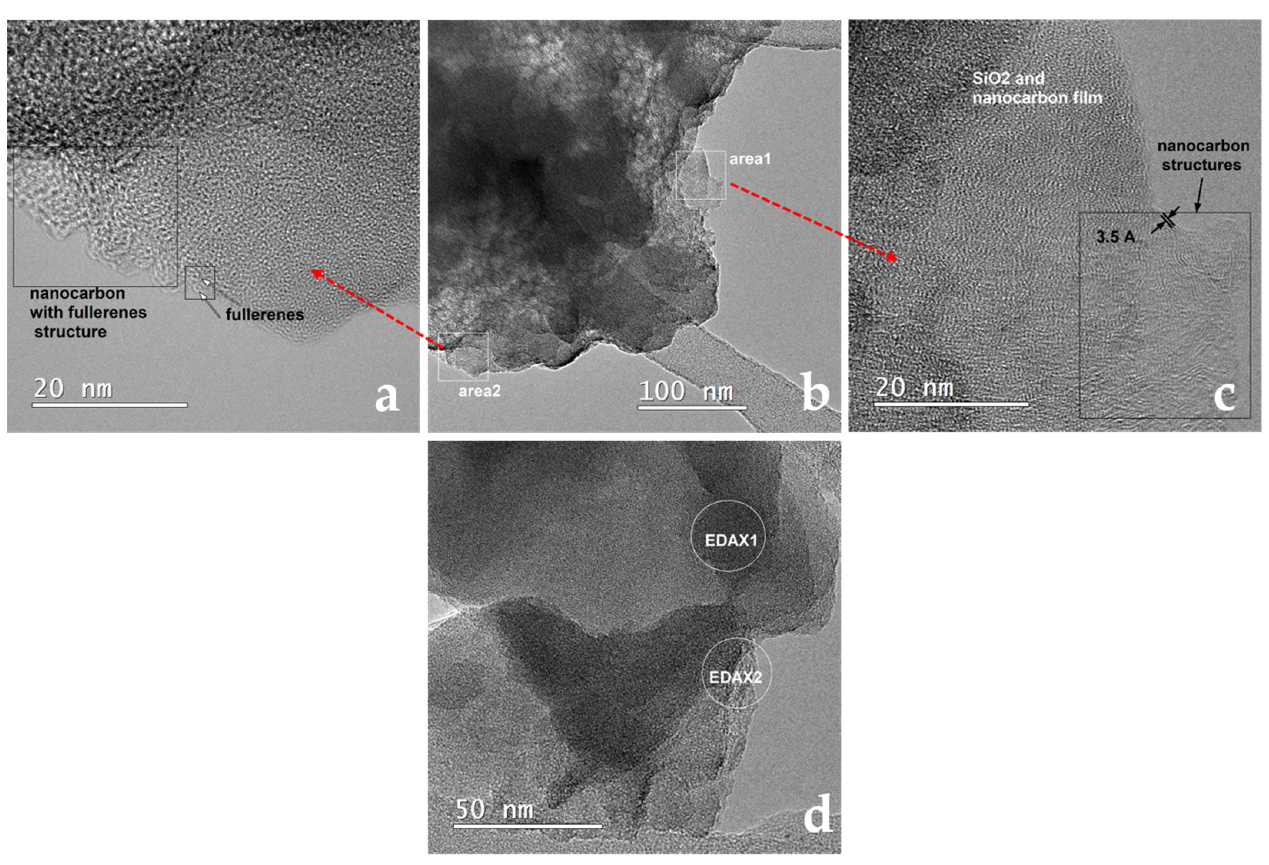
Figure 6. HRTEM image for the ( a ) C/SiO 2 -0.085 M—area2; TEM image for the ( b ) C/SiO 2 -0.085 M at low magnification; HRTEM image for the ( c ) C/SiO 2 -0.085 M area1; TEM image for the ( d ) C/SiO 2 -0.085 M.